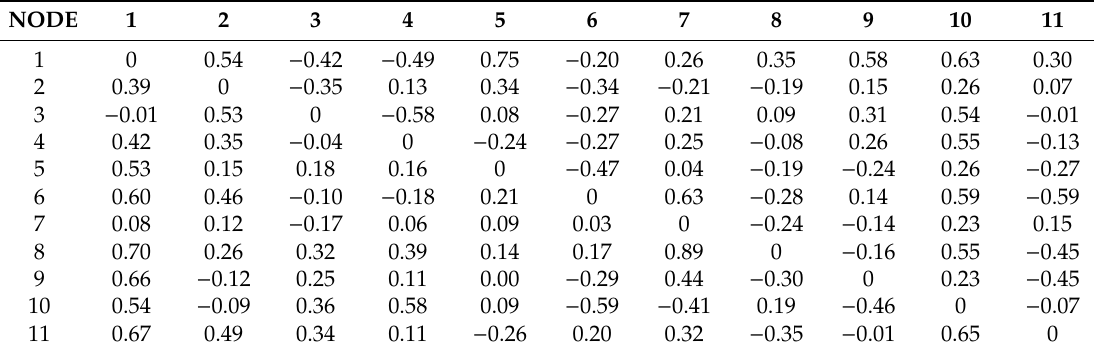
Table A8. Atletico Madrid’s individual Relative in-Transition